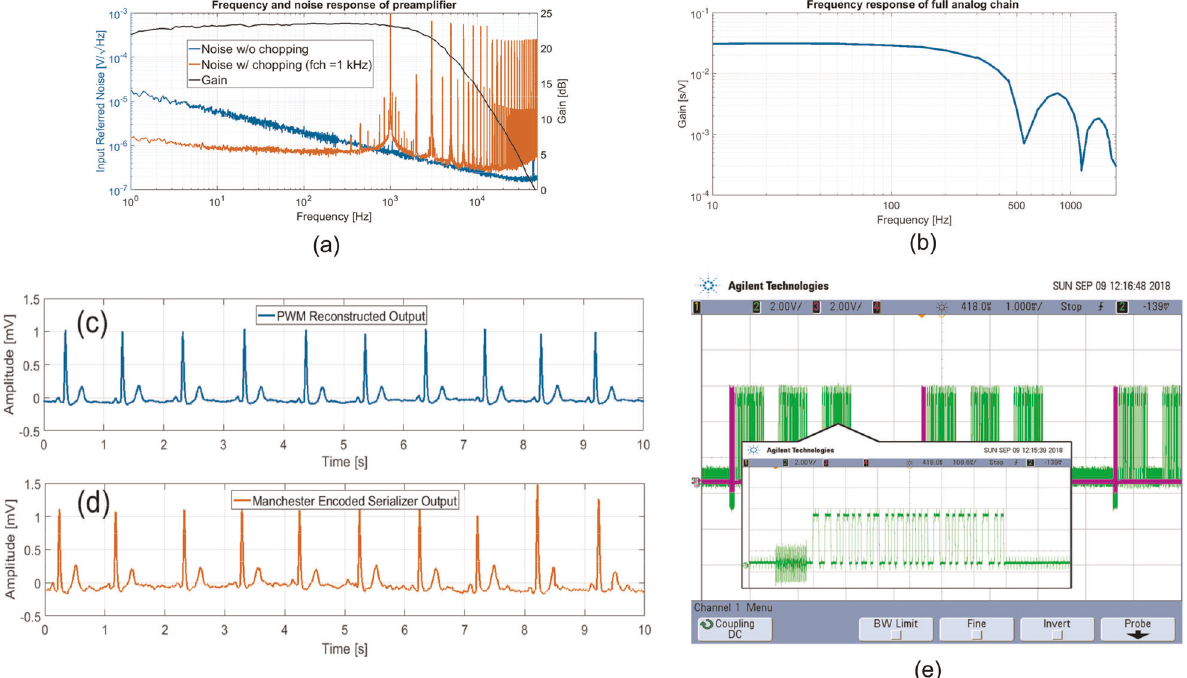
Fig. 4 Measurement results. a Measured frequency response and input-referred noise of the cascaded preampli fi er, b Measured transfer function of the full analogue chain (from Input to Output PWM), c In vivo ECG measured signal reconstructed from the output PWM, d In vivo ECG measured signal reconstructed from Manchester Encoded output, e Manchester Encoded output corresponding to three samples of the in vivo measurement and a zoom-in of the Manchester encoding of the output